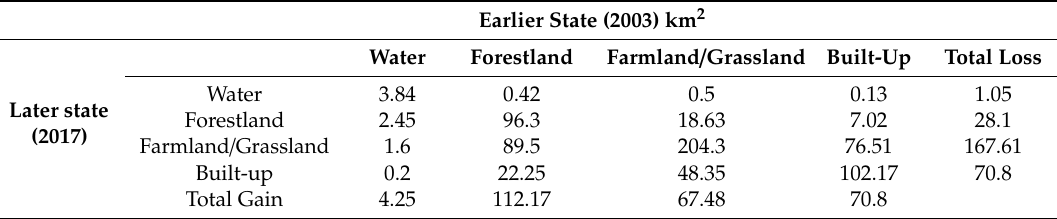
Table 6. Major LULC class changes from 2003 to 2017 from SPOT images.